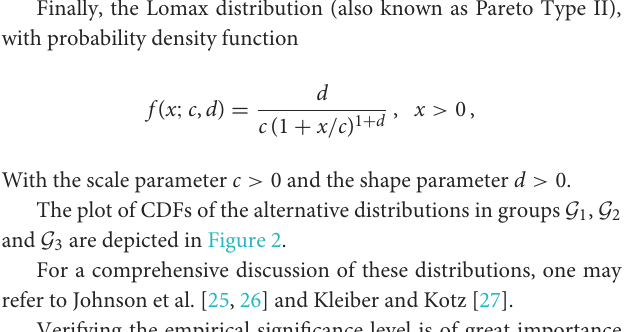
proportion F ( T ) is at least 60%. This shows the consistency of